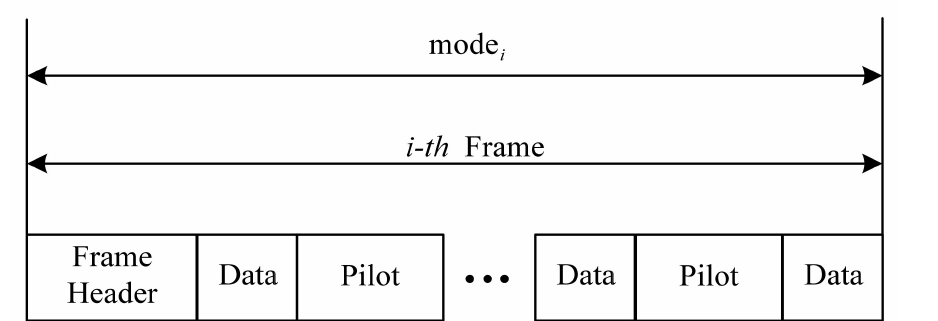
Figure 2. PL frame for the VM